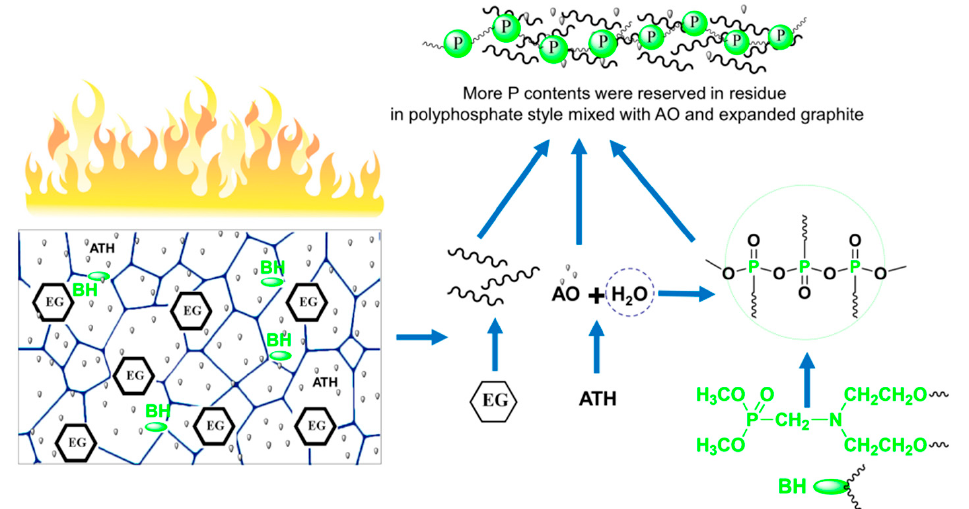
Figure 6. Flame retardant mechanism of ATH/BH/EG system in RPUFs.